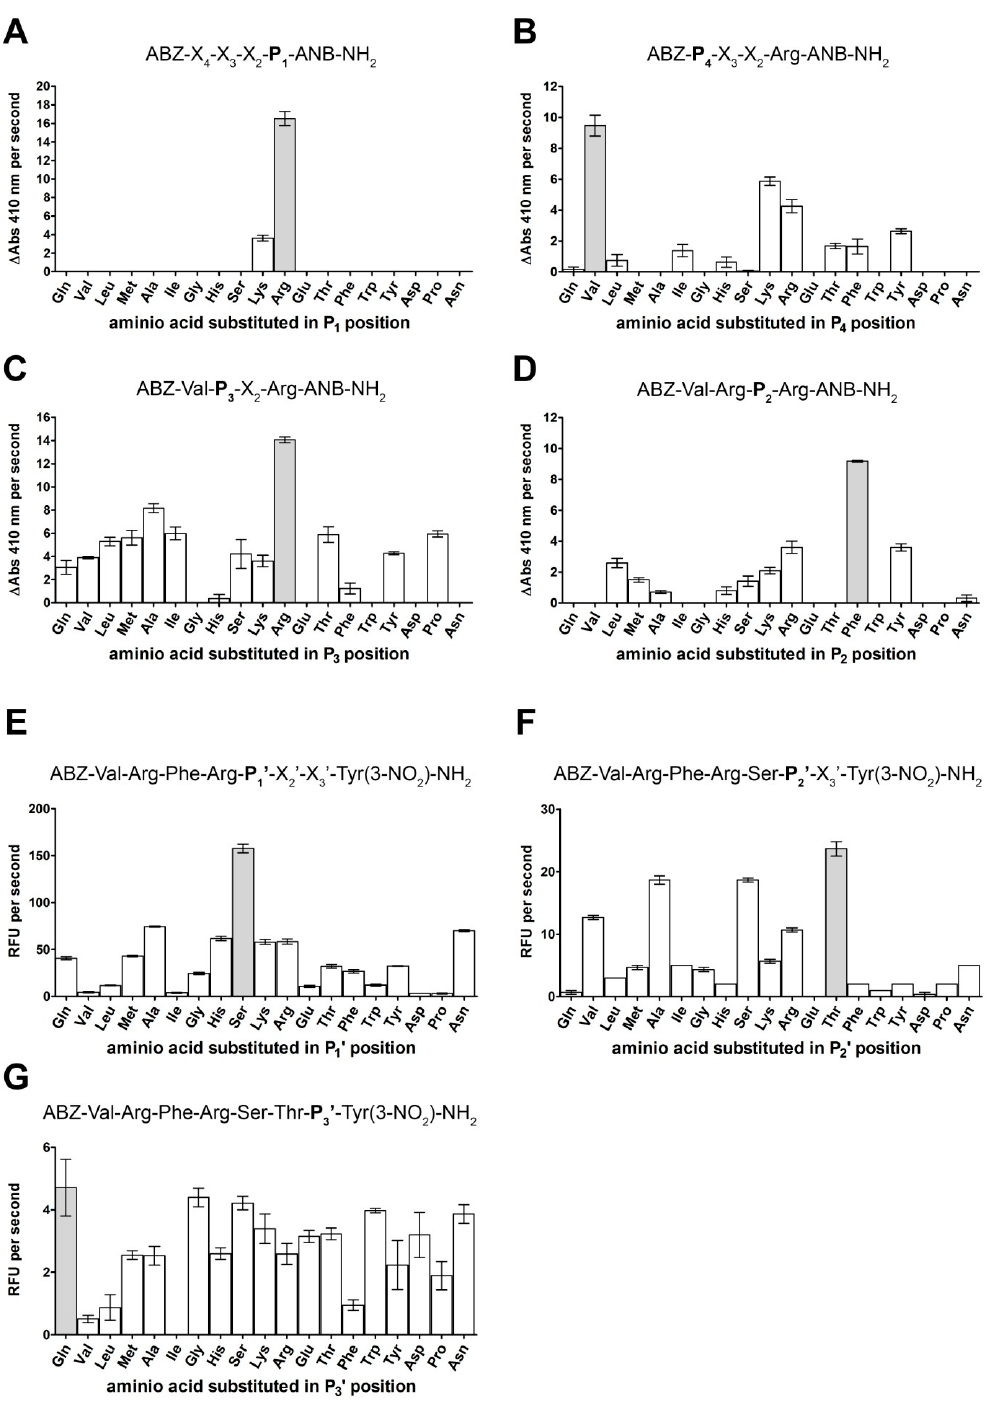
Figure 1. Substrate specificity of KLK13. Non-primed specificity was determined by deconvolution of ABZ-X 4 -X 3 -X 2 -Arg-ANB-NH 2 libraries. Each sub-library ( X -axis) was treated with KLK13 in 50 mM Tris-Cl (pH 7.5) containing 1 mM EDTA and 0.5 μ M heparin at 37 °C. Absorbance of released 5-amino-2-nitrobenzoic acid (ANB) was determined at 410 nm. Panel order reflects the deconvolution of the library, with P 1 resolved first ( A ), followed by P 4 -P 2 analysis ( B – D ). Primed subsites’ specificity was determined by deconvolution of the ABZ-Val-Arg-Phe-Arg-X 1 ′ -X 2 ′ -X 3 ′ -Tyr(3-NO 2 )-NH 2 libraries ( E – G ). Each sub-library was treated with the enzyme in 50 mM Tris-Cl (pH 7.5) buffer containing 1 mM EDTA and 0.5 μ M heparin at 37 °C. The fluorescence of released ABZ-peptide (excited at 320 nm) was monitored at 450 nm.